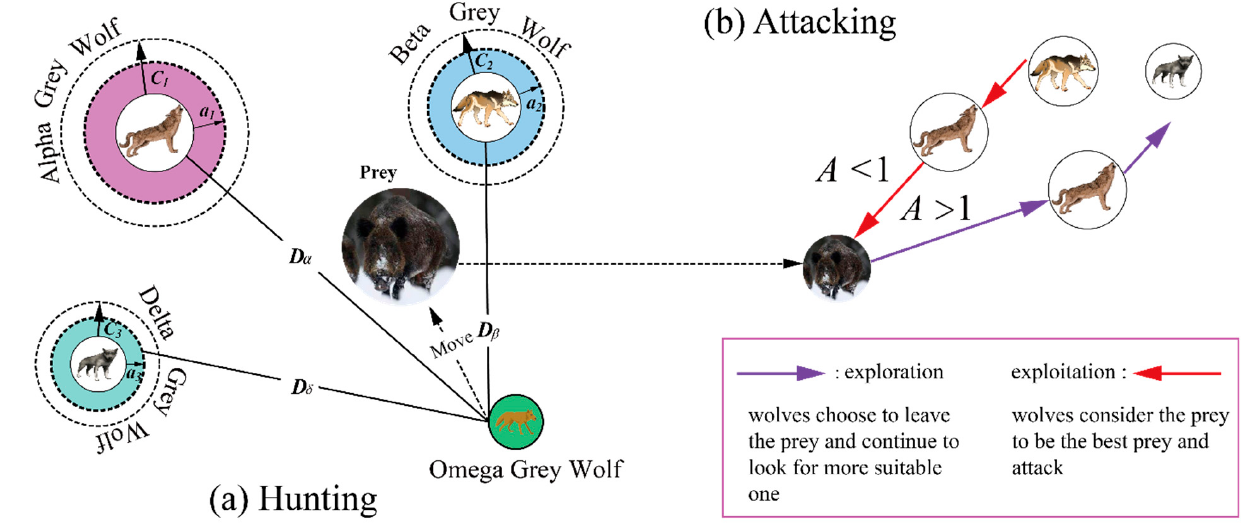
Figure 1. Schematic diagram of grey wolves hunting ( a ) and attacking ( b ).